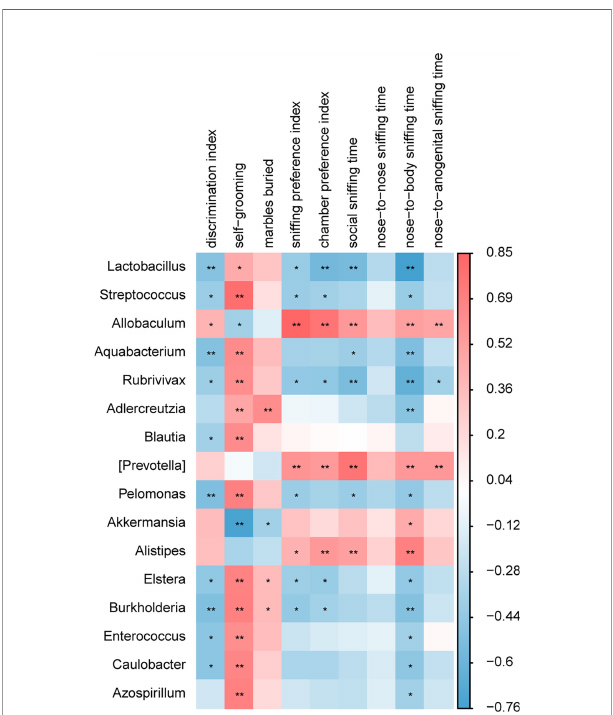
FIGURE 8 | A correlation between behavioral score and gut microbiota composition. A correlation matrix showing positive (red) and negative (blue) correlations between behavioral scores and relative abundance of bacterial genera. *p < 0.05, **p <